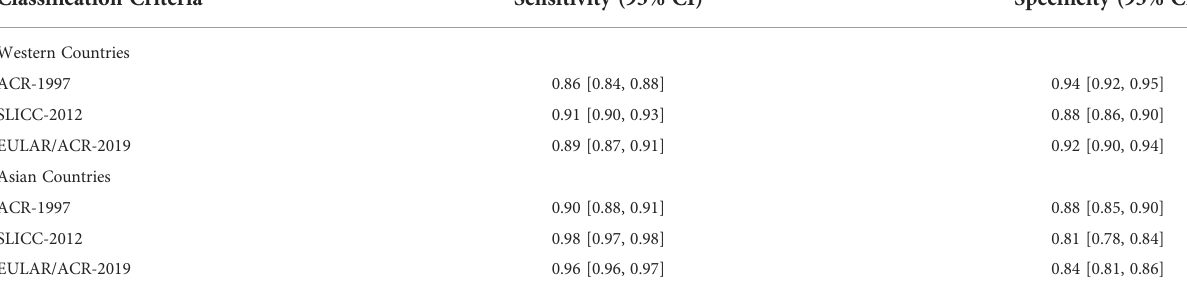
TABLE 2 Difference between the Western and Asian countries.